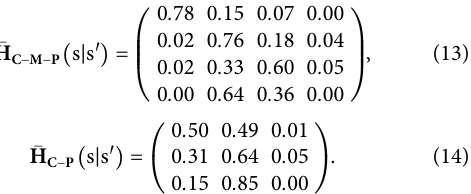
Algorithm 2. The simulated annealing optimizer to get a candidate core with fi xed core size.